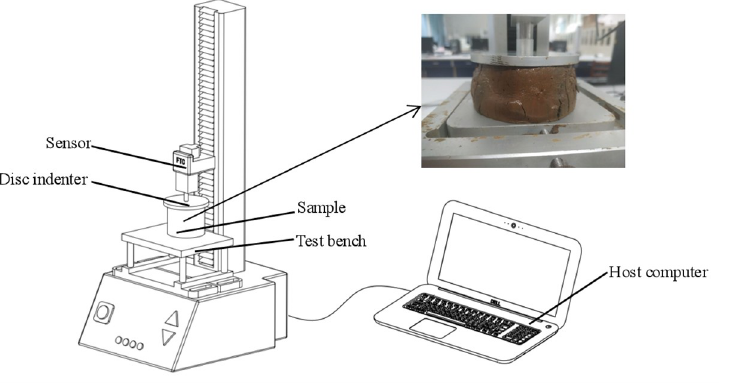
Fig 3. Creep test